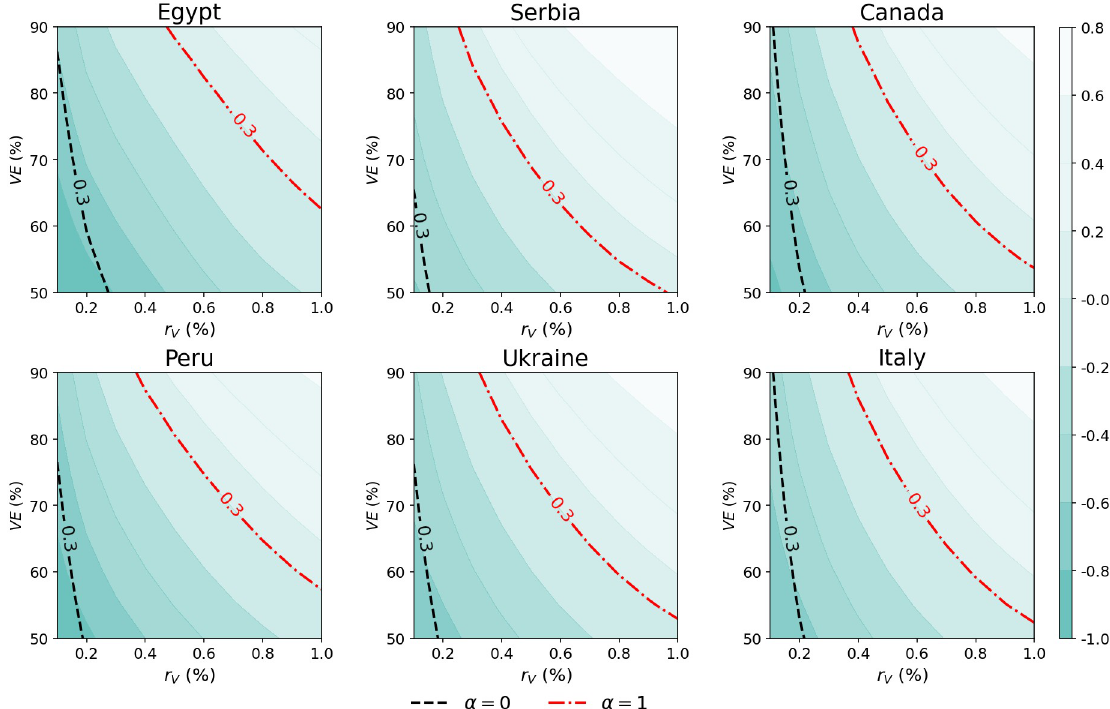
Fig 2. Interplay between vaccine efficacy and rollout speed. Contourplot of the relative deaths difference in the scenario with a mild . We let VE vary between 30% and 70% and we choose different behavioural response ( α = 1) for different combinations of VE and r V S VE Symp such that the overall efficacy VE vary between 50% and 90%. A 30% reduction of deaths is highlighted with a red dashdotted line. The black dashed line highlight the 30% death drop achieved with a vaccination campaign without the behavioural component ( α = 0). Vaccination Strategy 1 is considered, parameters used are γ = 0.5, R 0 = 1.15, r = 1.3, 0.5% of initially infected, 10% of initially immune individuals, and simulations length is set to 1